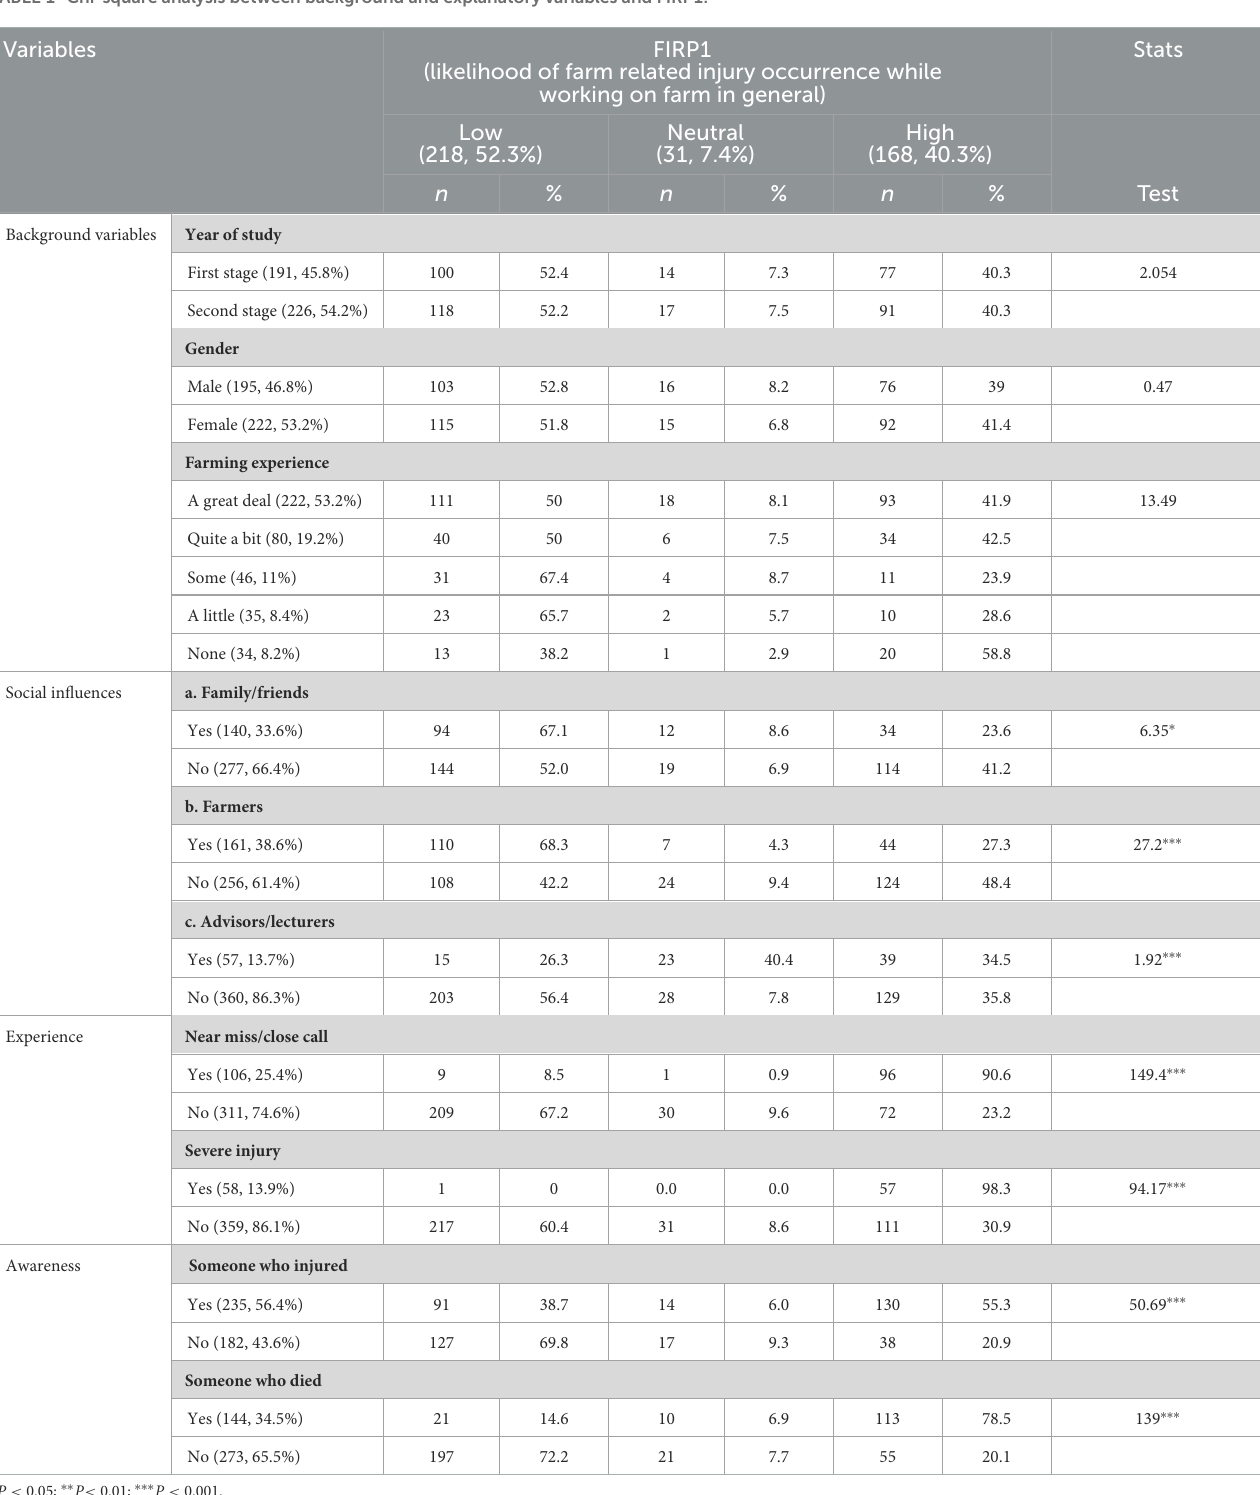
TABLE 1 Chi-square analysis between background and explanatory variables and FIRP1. Variables FIRP1 (likelihood of farm related injury occurrence while working on farm in